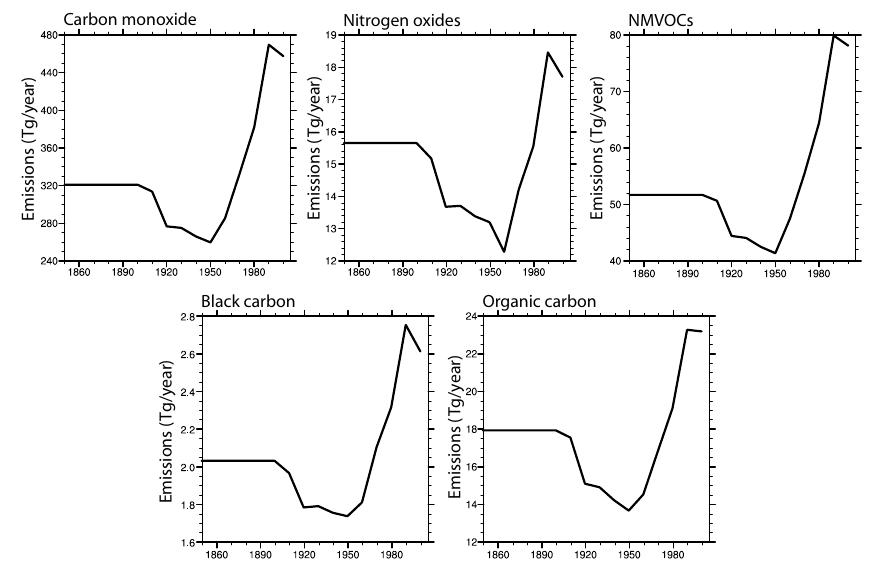
Fig. 3. Time evolution of the total open biomass burning (forest and grassland) emissions for carbon monoxide (Tg(CO)/year), NO x (Tg(NO 2 )/year), NMVOC (Tg(NMVOC)/year, black carbon (Tg(C)/year) and organic carbon (Tg(C)/year). and boreal